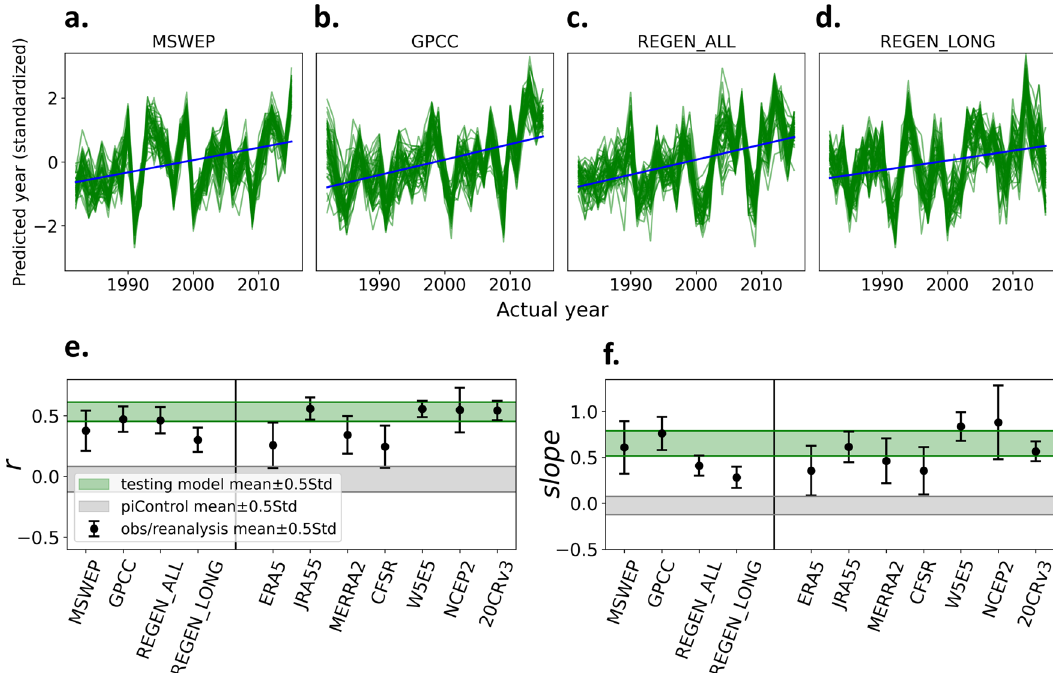
Fig. 4 Metrics of the forced signal in observation-based estimates of precipitation during 1982 – 2015. a – d Actual year vs predicted year obtained from 51 different arti fi cial neural networks (ANNs) with different training/validation/testing sets, for four observational datasets, MSWEP ( a ), GPCC ( b ), REGEN_ALL ( c ), and REGEN_LONG ( d ). Green lines show results from each ANN. The blue line is the mean slope. Each predicted year time series is standardized in the fi gure for a better comparison between datasets. e Correlation ( r ) between the actual years and predicted years, ( f ) slope of the regression line between actual years and predicted years for observational and reanalysis data (black circle with a line), and testing models (green-shaded regions). Gray shading represents a measure of natural variability derived from 220 nonoverlapping 34-year segments obtained from pre-industrial control (piControl) simulations (see “ Methods ” ). The error bar range and the range of the green and gray-shaded area show the ±0.5 standard deviation